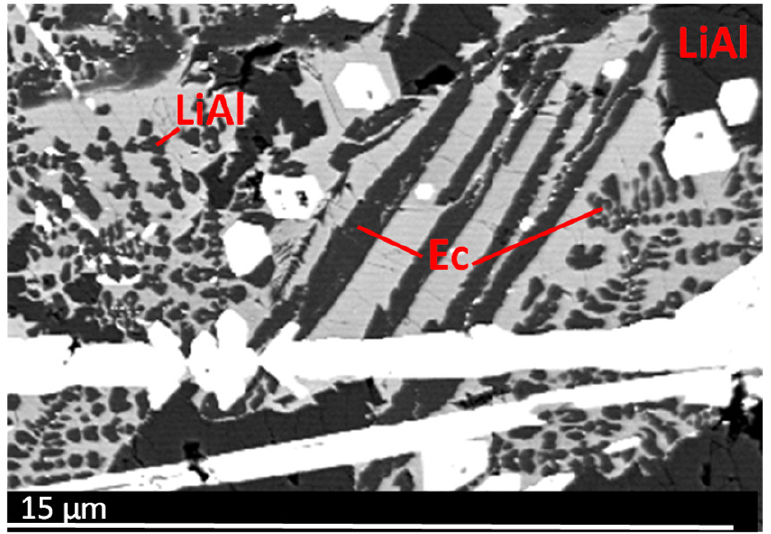
Figure 6. BSE(Z) micrograph of a section containing lath-shaped xenomorphic grains of Ec in ASSB- 10.